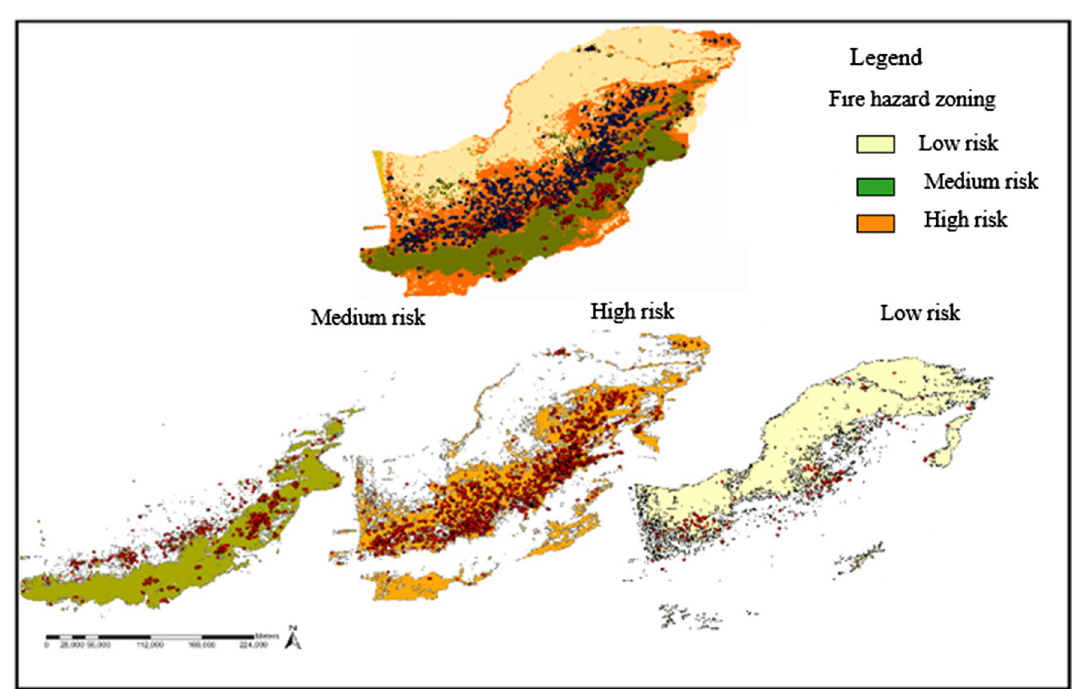
Fig. 8 Fire risk zones based on fire